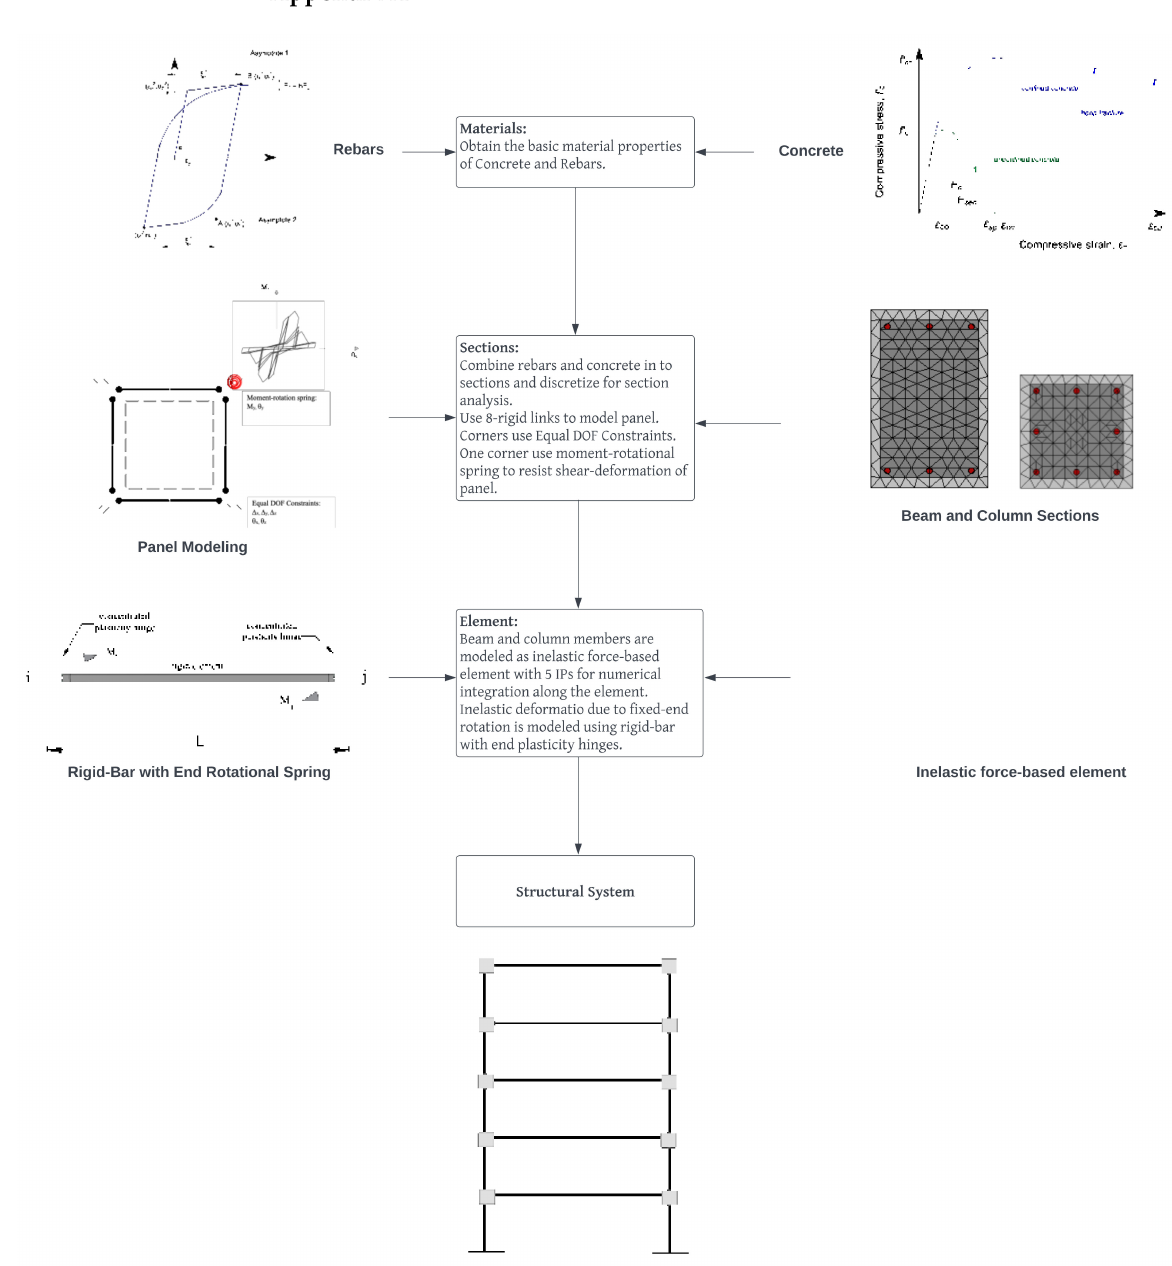
Figure A1. Simplified flowchart for preparing numerical model of structural system.